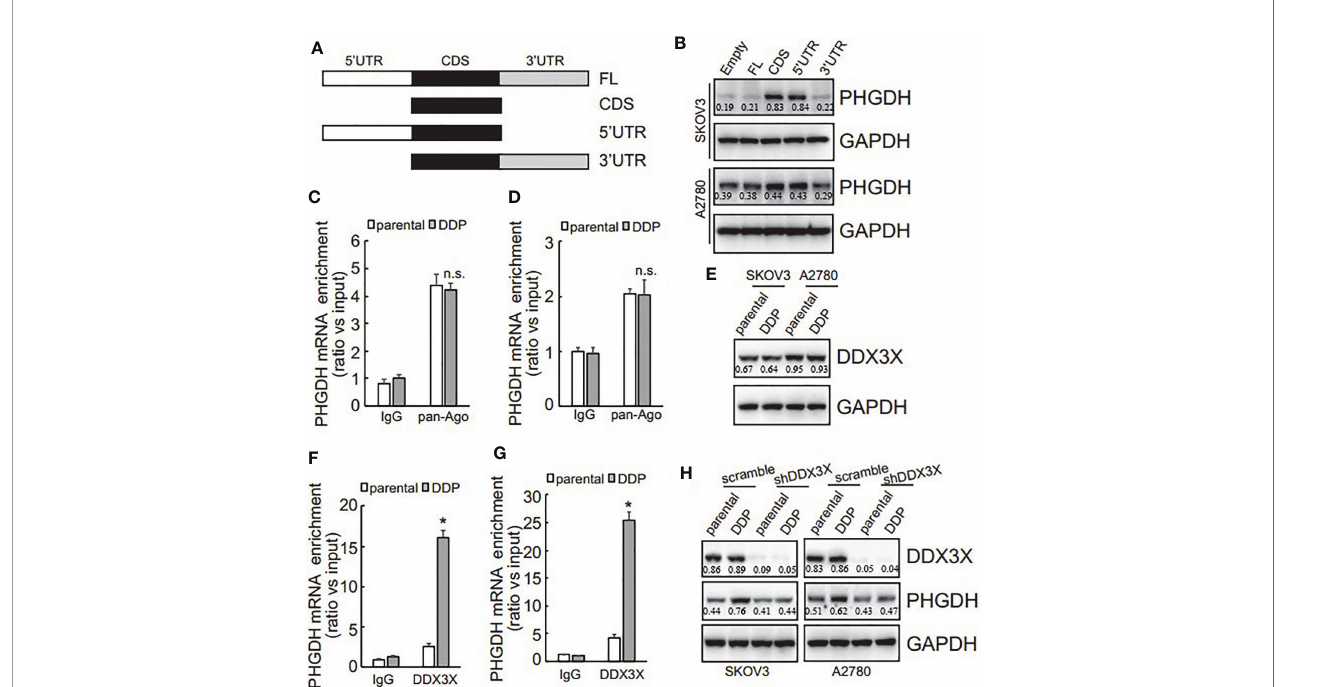
FIGURE 5 | PHGDH expression is upregulated via 3 ’ UTR of its transcript in a DDX3X-dependent pattern. (A) The PHGDH expression pMIR-REPORTTM Luciferase vectors were cloned as illustrated. (B) cells were transfected with empty pMIR-REPORTTM Luciferase vector (empty) and PHGDH vector (FL, CDS, 5 ’ UTR, 3 ’ UTR), and ectopic PHGDH expression was investigated using Western blot analysis. (C, D) RIP was performed using IgG or pan-Ago antibody from control and DDP paired A2780 (C) or SKOV3 (D) cells, and enrichment of PHGDH mRNA was evaluated using qRT-PCR. (E) DDX3X expression was analyzed using Western blot analysis. (F, G) RIP was performed using IgG or DDX3X antibody from control and DDP paired A2780 (F) or SKOV3 (G) cells, and enrichment of PHGDH mRNA was evaluated using qRT-PCR. (H) Cells were infected with pGCLV-GV166 lentivirus vector (scramble) or shRNAs against DDX3X (shDDX3X), PHGDH expression was analyzed using Western blot. * P < 0.05, n.s., not signi fi